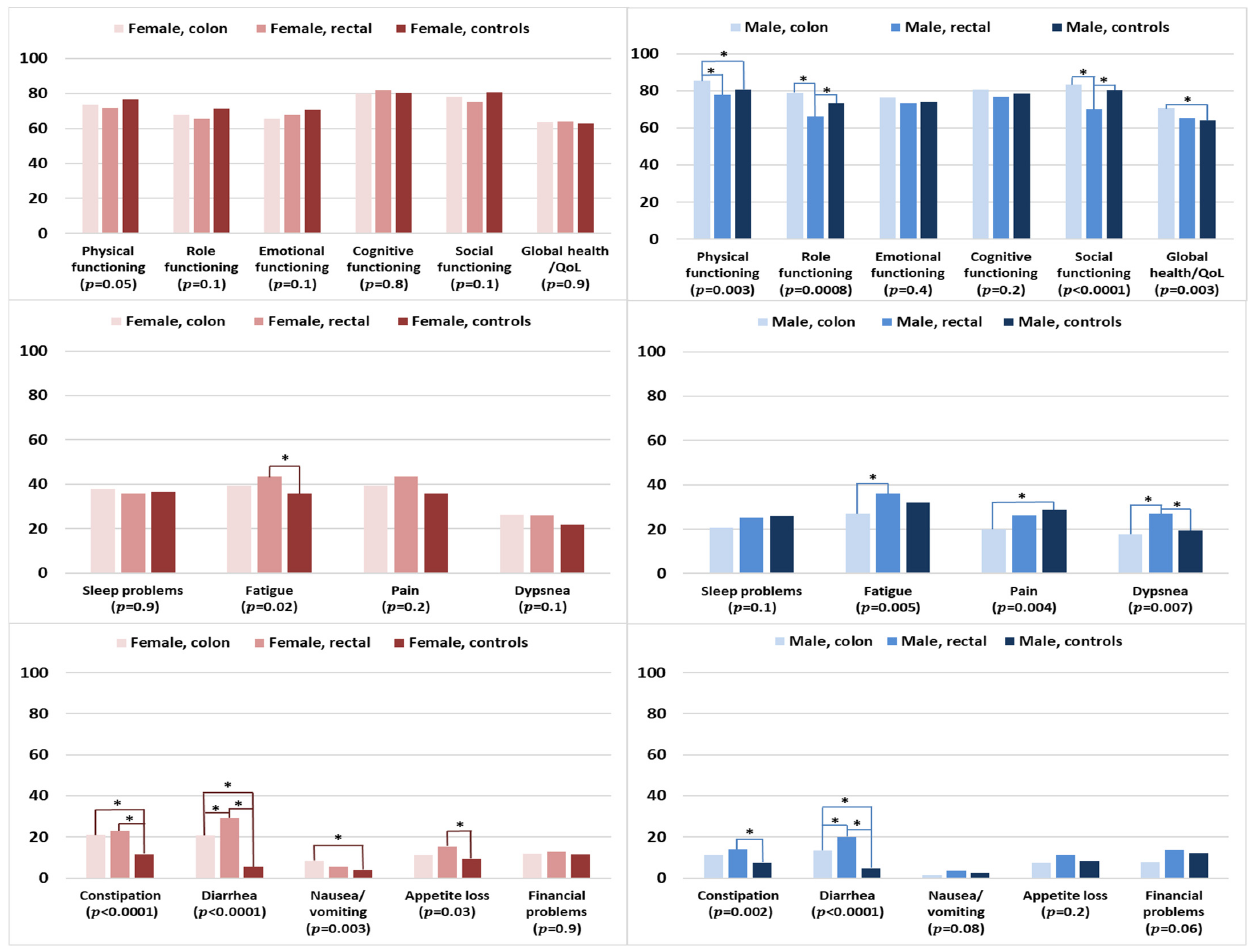
Figure 5. Mean EORTC QLQ-C30 scores of survivors (colon and rectal cancer) and controls, stratified by sex. Models are adjusted for age at survey and education. The p -values shown indicate the global comparison between cancer survivors and controls, separated by sex. The line spans and asterisks (*) indicate the subgroups that showed significant differences in pairwise comparison. For example, the line span for physical functioning in male colon survivors is across three columns, indicating that male colon survivors reported significantly higher physical functioning when compared with male controls. All results are based on 25 imputations of missing values.